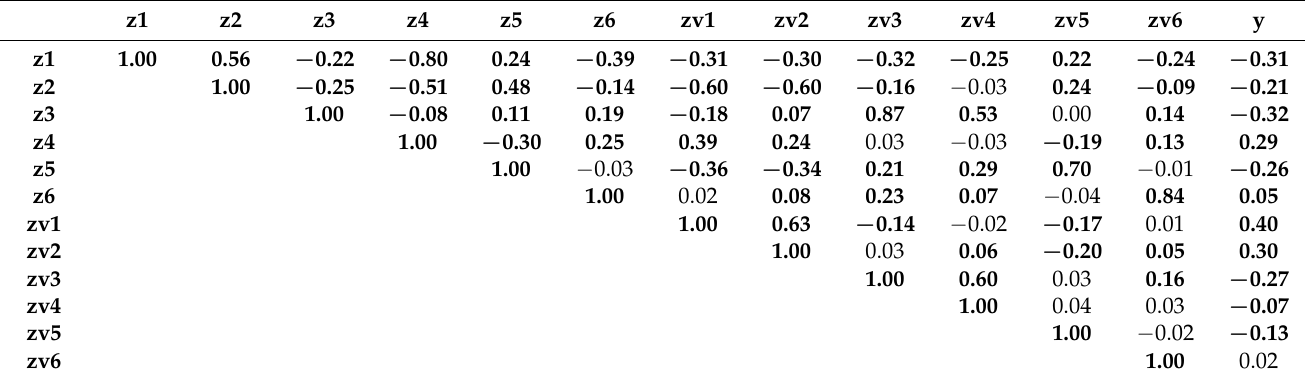
Table 7. Correlations among next-day PM 2.5 levels and meteorological factors (nationwide daily average and variance).